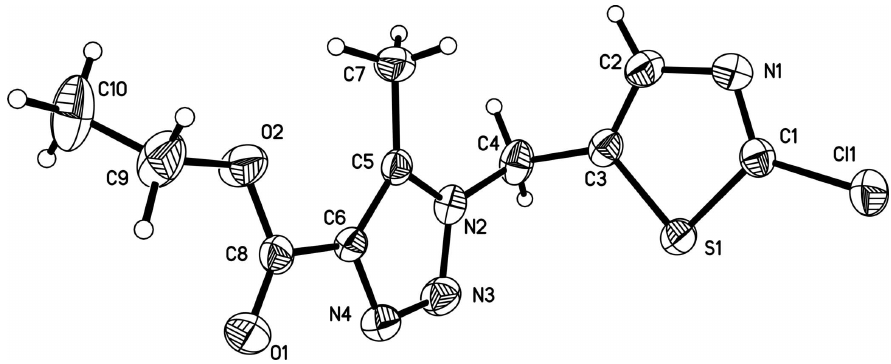
Figure 1 View of the molecular structure of (I), showing the atom labelling scheme and with displacement ellipsoids drawn at the 50% probability level.